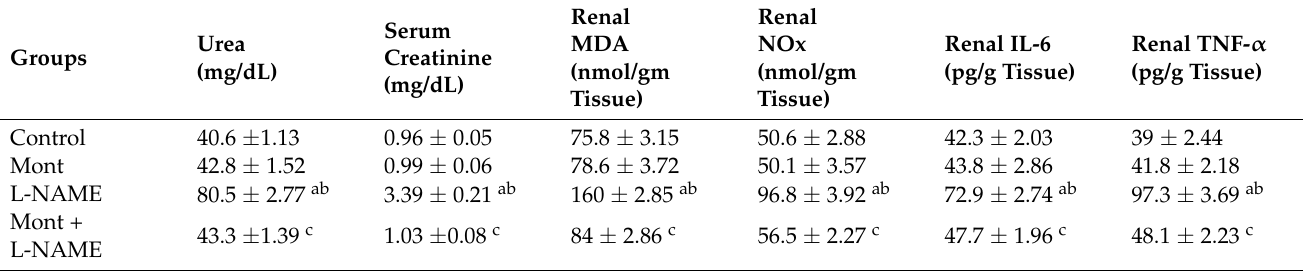
Table 3. Effect of montelukast on renal parameters in a pre-eclampsia model in